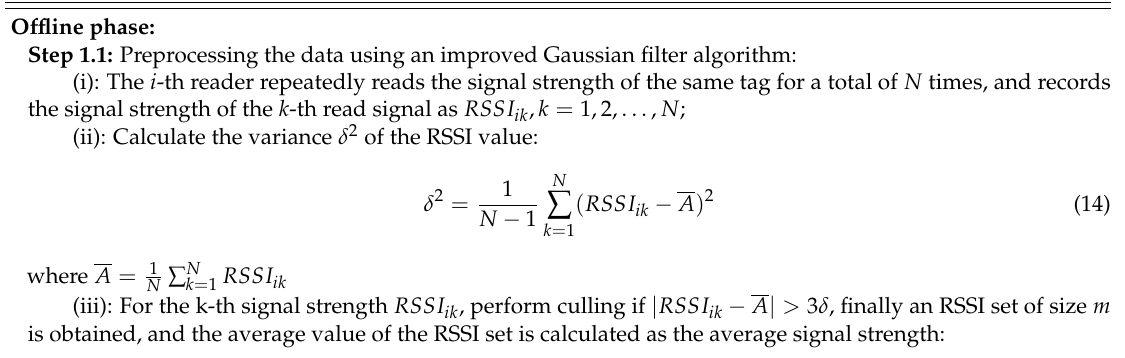
Procedure 3 Semi-Supervised Online Sequential Extreme Learning